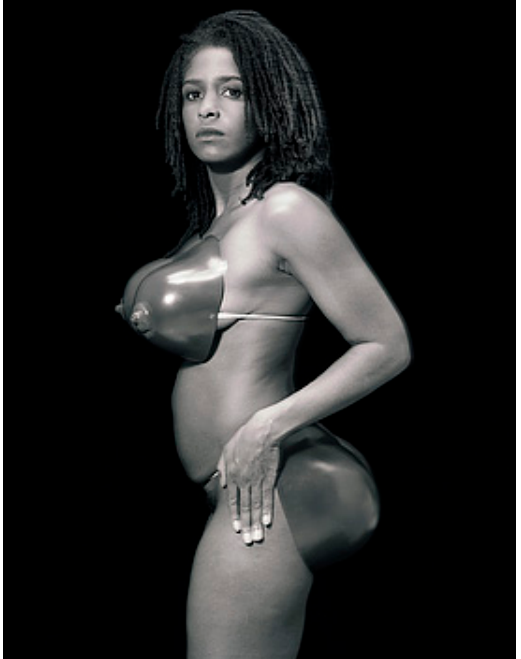
Figure 2. Renee Cox’s Venus Hot ‐ En ‐ Tot, 1994; self ‐ photographed. “The artist grants permission to download the artist’s images from the website for non ‐ commercial use or for fair use as defined in the United States copyright laws.”